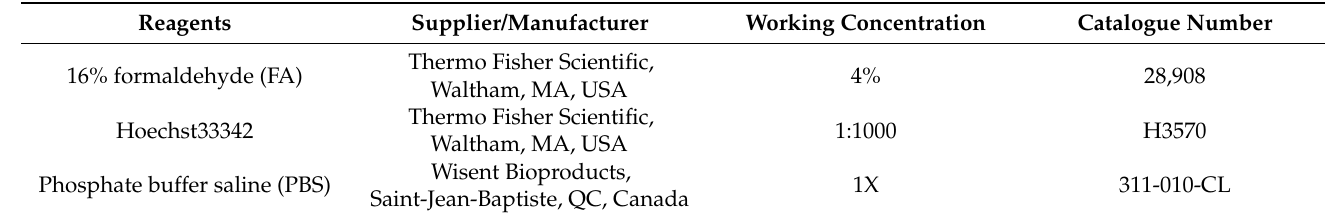
Table 5. List of reagents .